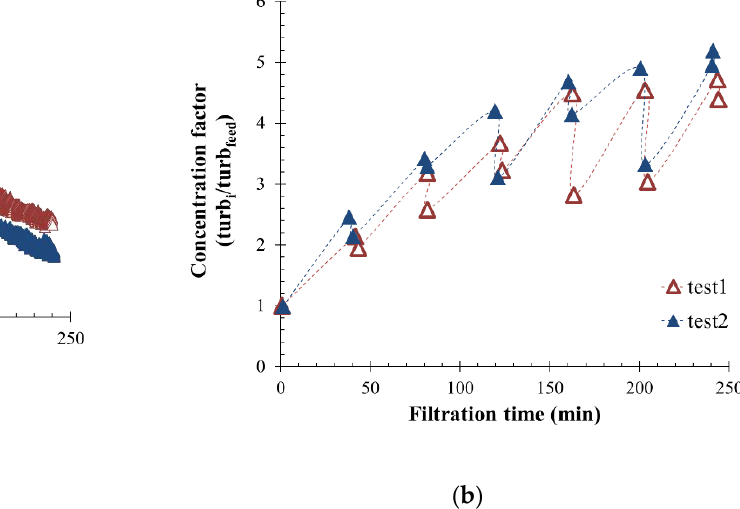
Figure 4. Repeatability experiment with a permeate flux of 90 L h −1 m −2 . Variation of permeability at 20 °C ( a ) and turbidity concentration factor from the feed value ( b ) throughout the time with backwash water injected for 5 s every 40 min. T = 20 °C, feedwater from CC-KERGUELEN; SiC membrane 0.33 m 2 . Jxx is permeate flux at the xx value in L h −1 m −2 ; 1BW yy s/zz min where yy is the duration and zz the interval of filtration between two BF; and Rw is the total recovery rate applied on the unit.